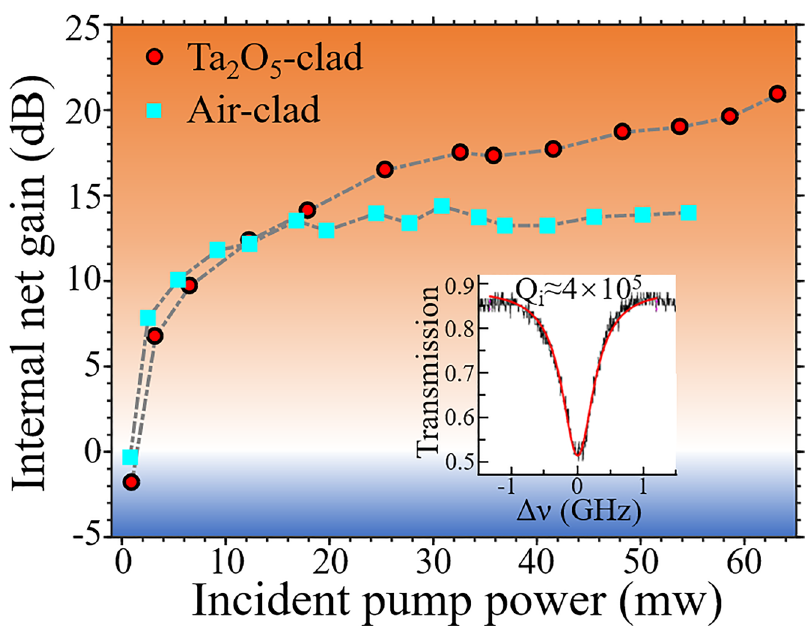
Figure 3: The internal net gain measured from the air-clad (blue squares) and Ta 2 O 5 - clad (red circles) ampli fi ers. The optical transmission curve around the resonant wavelength of 1532 nm in the Er 3 + :LNOI WGM-microcavity is shown in the